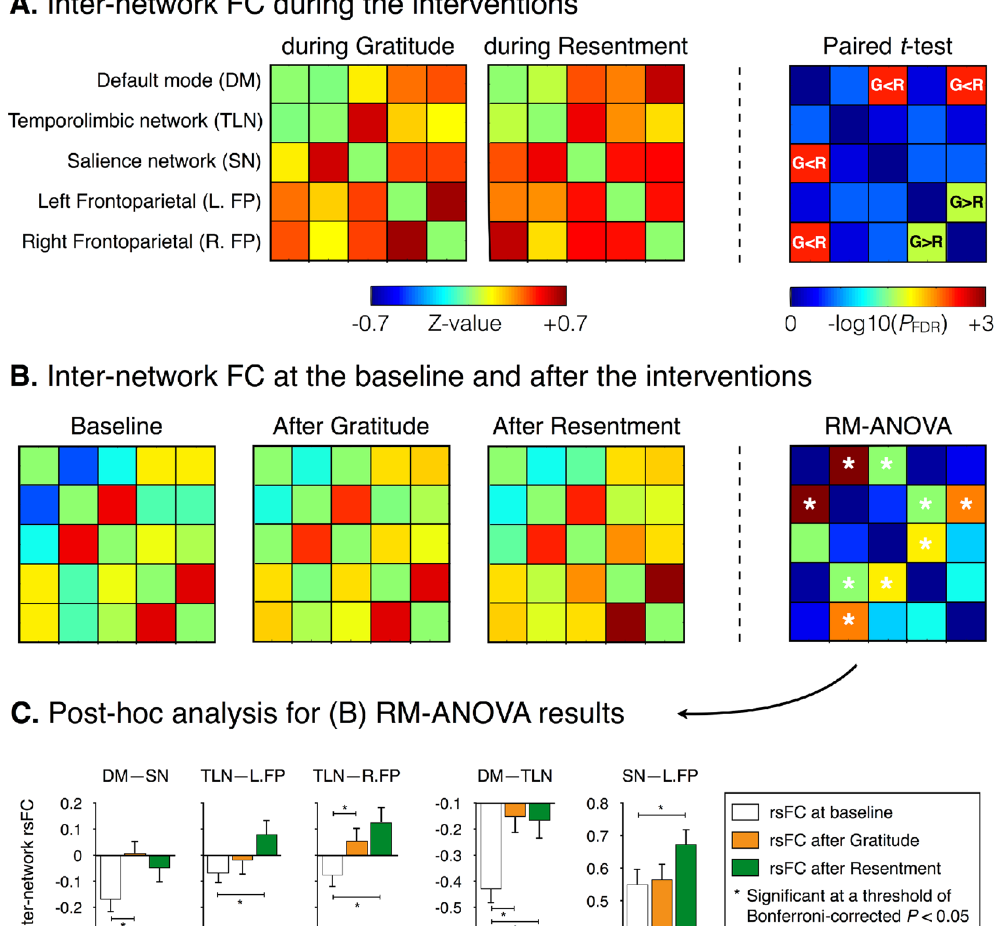
Figure 3. Inter-network functional connectivity (FC) among five functional networks during the gratitude and resentment interventions ( A ) and after the interventions ( B ). Average inter-network FC values across subjects before, during, and after the interventions are shown in insets ( A and B ). Paired sample t-tests were conducted to compare inter-network FC during the two interventions. Meanwhile, repeated-measures analysis of variance (RM-ANOVA) tests were performed to compare inter-network FC before and after the interventions. The detailed descriptions for the mean, standard deviation, and statistical value are summarized in Supplementary Tables S9 and S10. As shown in the last column in insets ( A and B ) statistical significances were presented in the form of − log10 ( P FDR ), where P FDR is the corrected p -value for multiple comparisons using false discovery rate (FDR). Furthermore, post-hoc analysis was carried out for significant inter-network FCs in the RM-ANOVA test ( C ). Standard errors on a bar graph were plotted in an inset ( C ). Abbreviations: G > R (G < R) indicates that inter- network FC during the gratitude is higher (lower) than that of during the resentment; rsFC, resting-state